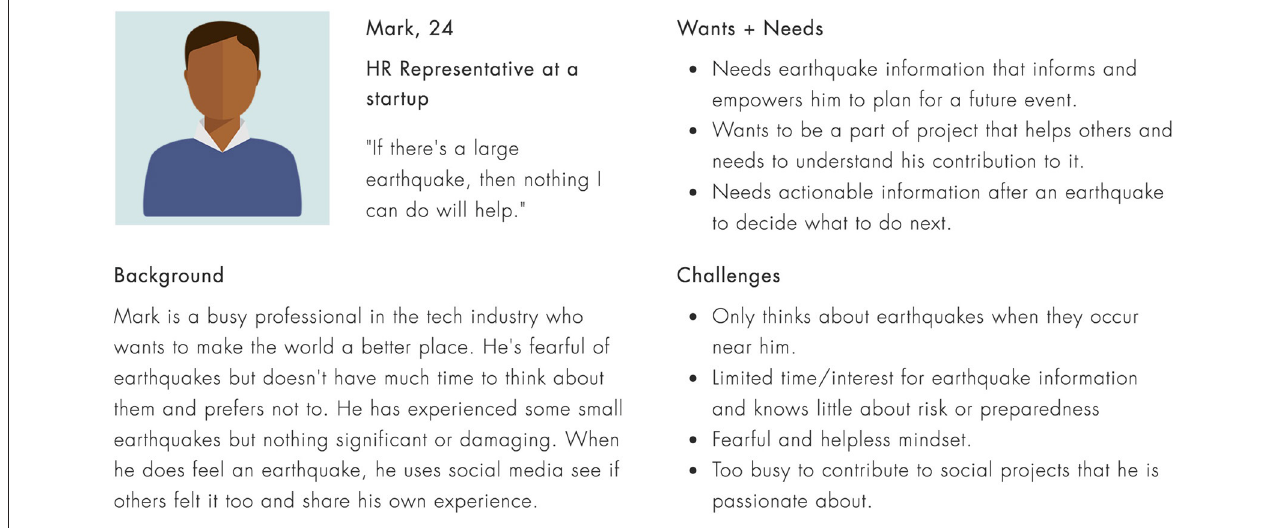
FIGURE 5 | Representative persona that was developed from the user interviews.